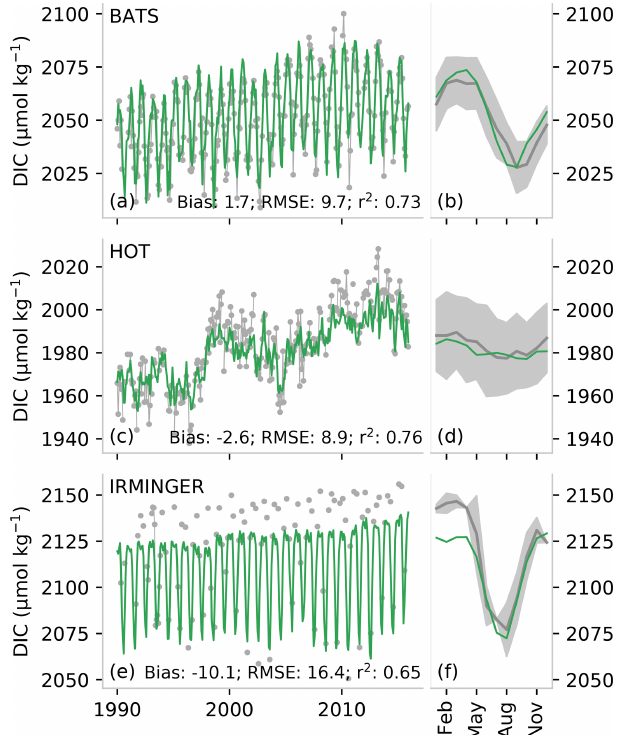
Figure 6. A comparison of observations from long-term obser- vation stations (gray) with predicted dissolved inorganic carbon (DIC). The top row (a, b) shows data for the Bermuda Ocean Time- series Study (BATS), the middle row (c, d) shows data for the Hawaii Ocean Time-series (HOT), and the bottom row (e, f) shows data for the Irminger station. The narrow panels on the right show the average of the seasonal climatology for the time series, where the gray shading shows the standard deviation of the observations for the period 1990 to 2018, while the green line shows the average estimate.